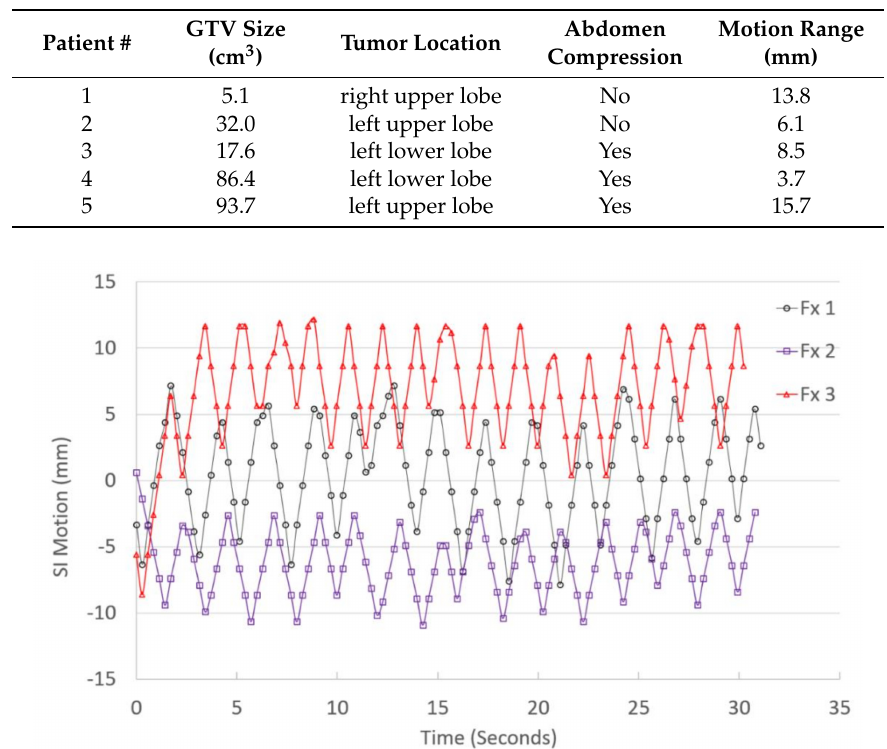
Table 1. List of patients and their characteristics including tumor motion range obtained from four-dimensional CT scans. GTV, gross tumor volume.